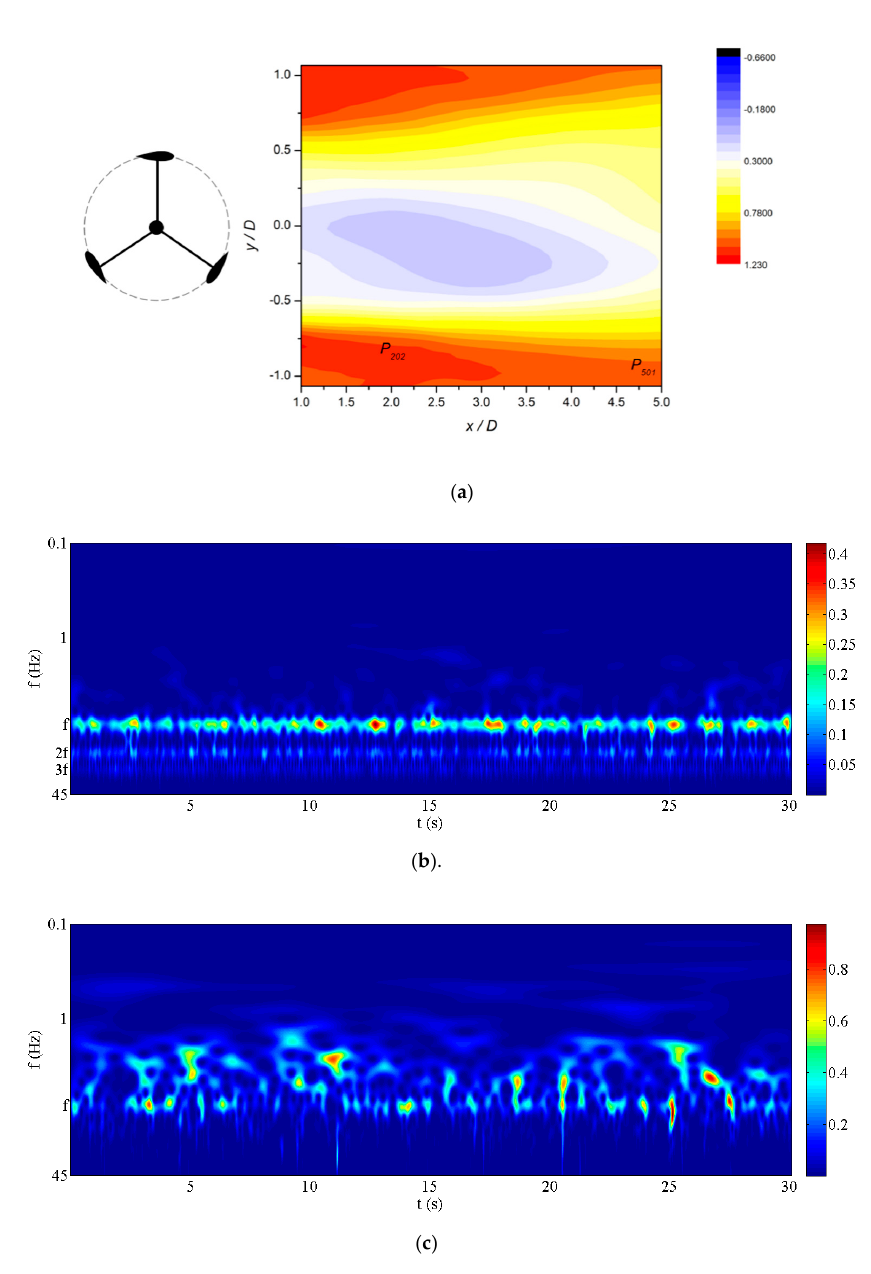
Figure 7. The wavelet spectrum of the time series signal of the streamwise fluctuating velocity at different positions of the turbine wake with configuration B, n = 3, c = 81mm: ( a ) schematic diagram, di ff erent positions of the turbine wake with configuration B, n = 3, c = 81 mm: ( a ) schematic diagram, ( b ) P 202 , ( c ) P 501 . ( b ) P 202 , ( c ) P 501